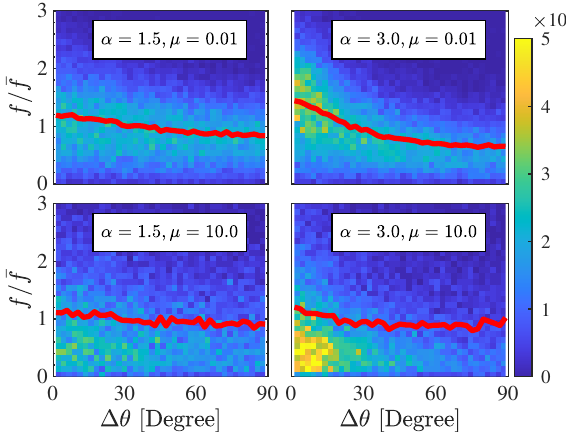
Figure 1. The bi-variate PDF of contact pairs as a function of ∆ θ and f / ¯ f . The colour scale provides the probability density. The red lines show the mean contact force ¯ f as a function of ∆ θ